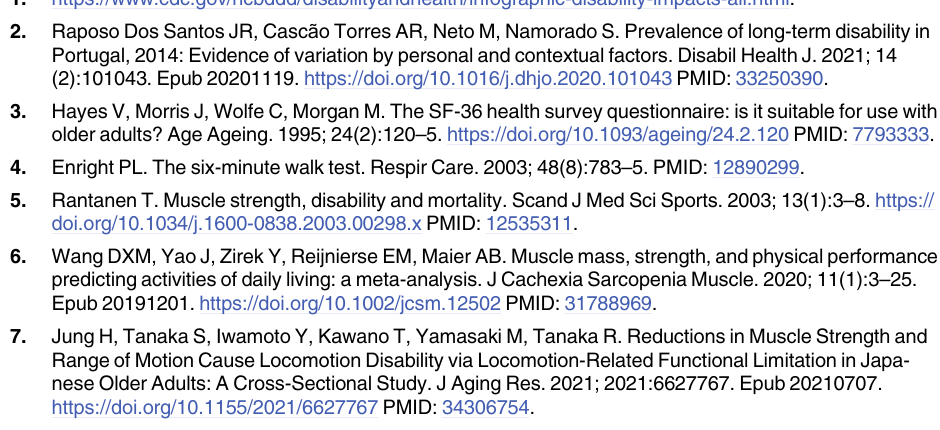
S1 Table. Individual intra-rater intra-class correlation coefficients (ICC) of knee extension strength measured with hand-held dynamometers using average, maximum and first val- ues within AB and CD assessments for all the